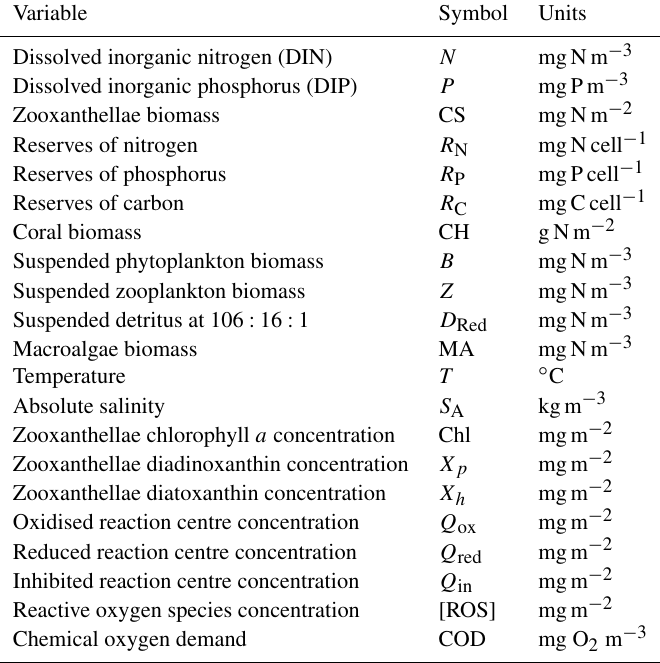
Table 24. Model state variables for the coral polyp model. Note that water column variables are three-dimensional, benthic variables are two-dimensional, and unnormalised reserves are per